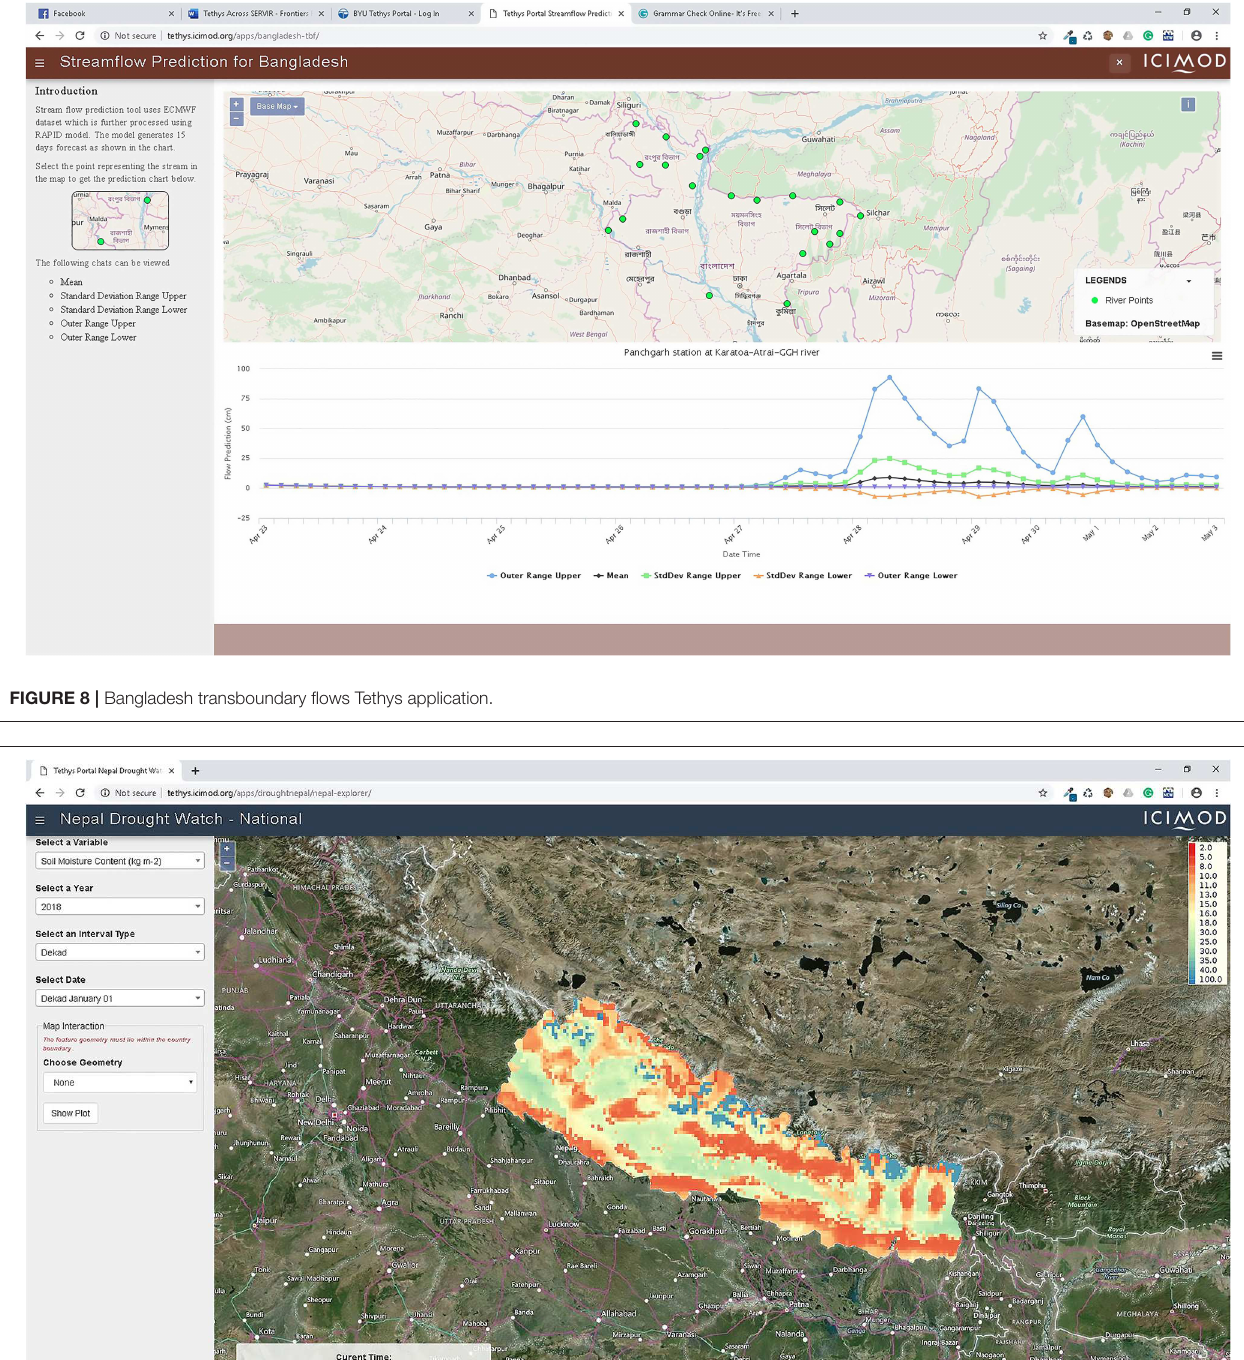
Regression Downscaling (GARD) tool (Gutmann et al., 2018). The resulting forecasts are used to generate probabilistic forecasts of drought indicators defined in consultation with end users